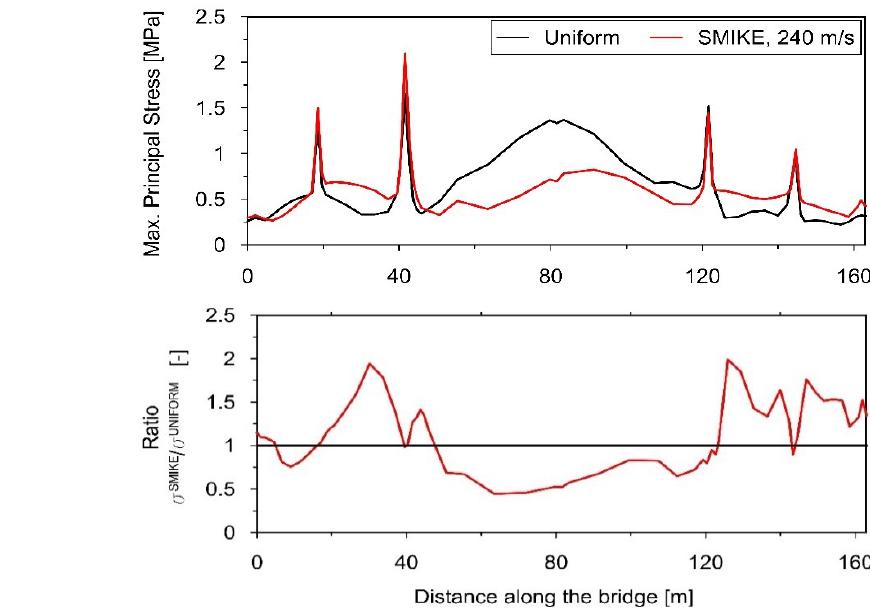
Figure 17. The SMIKE Model (red line) vs. the Uniform Model of Excitation (black line): ( a ) the comparison of the maximal principal stress envelopes, ( b ) the stress envelope ratio: SMIKE to uniform model.